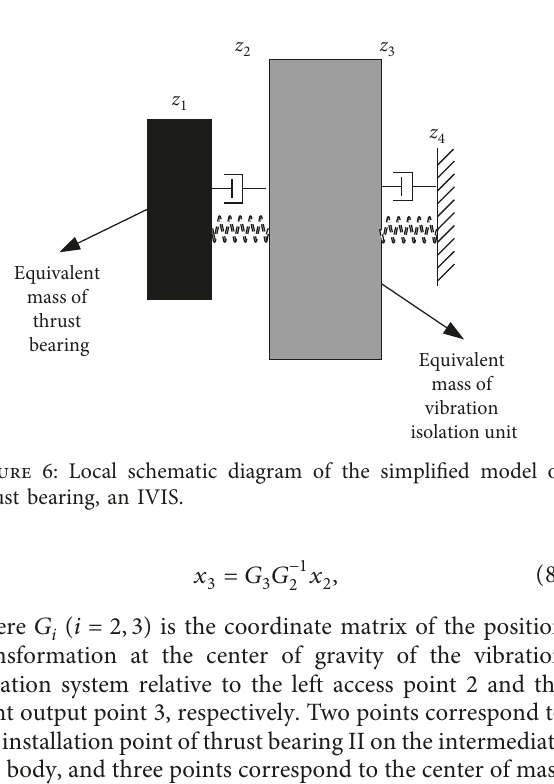
Figure 5: Two modeling methods of thrust bearing. (a) Single-DOF. (b) Multi-DOF.